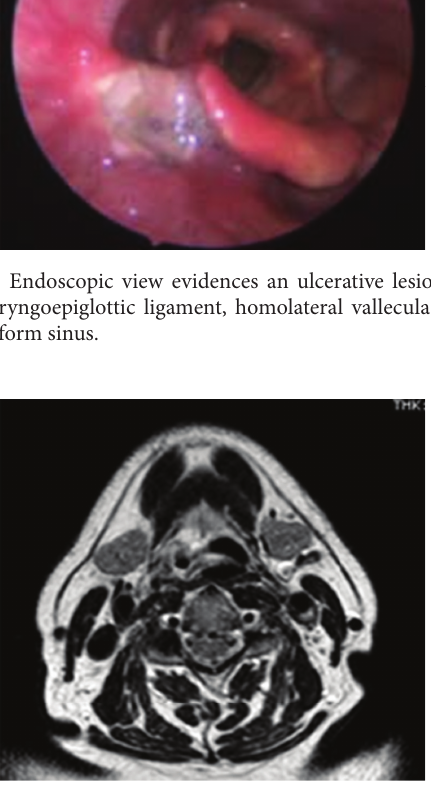
Figure 2: MR image shows an irregular area of tissue thicken- ing with moderate contrast enhancement on the right pharyngo- epiglottic ligament and omolateral pyriform sinus.